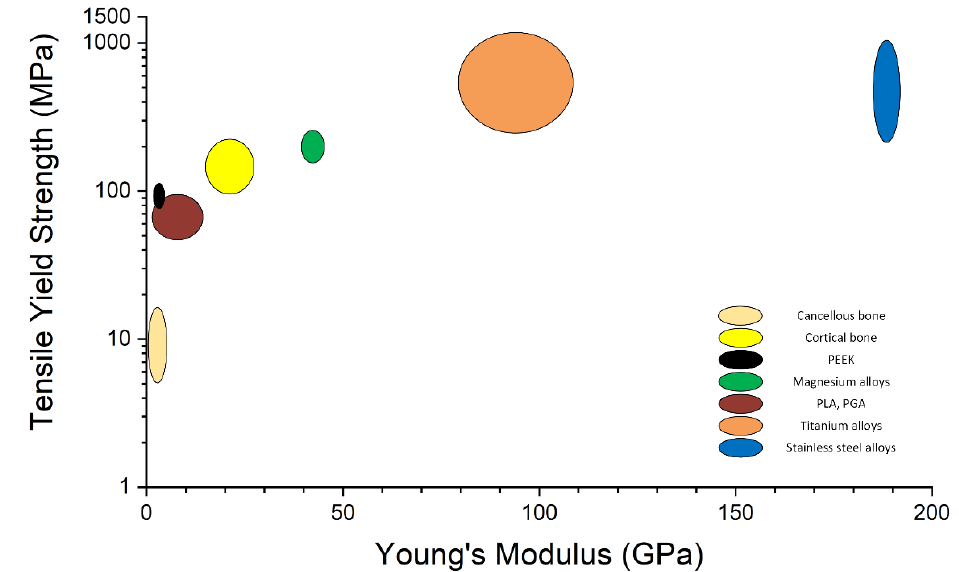
Figure 2. Ashby plot for different materials used in orthopedic implant manufacture.